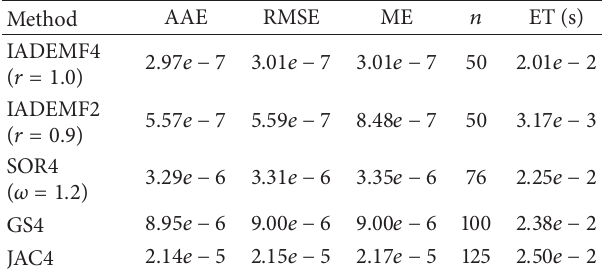
Table 3: Experiment 1. 𝑚 = 700 , 𝜆 = 1.0 , Δ𝑥 = 1.43 × 10 −3 , Δ𝑡 = 2.04 × 10 −6 , 𝑡 = 5.09 × 10 −5 , and 𝜀 = 10 −6